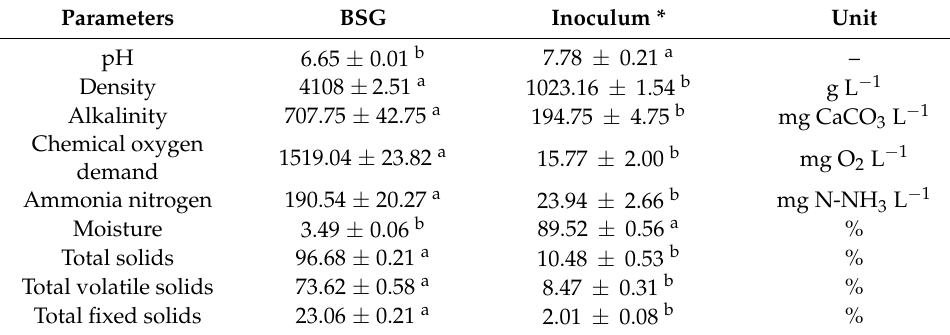
Table 1. Characterization of BSG and mesophilic inoculum. Parameters